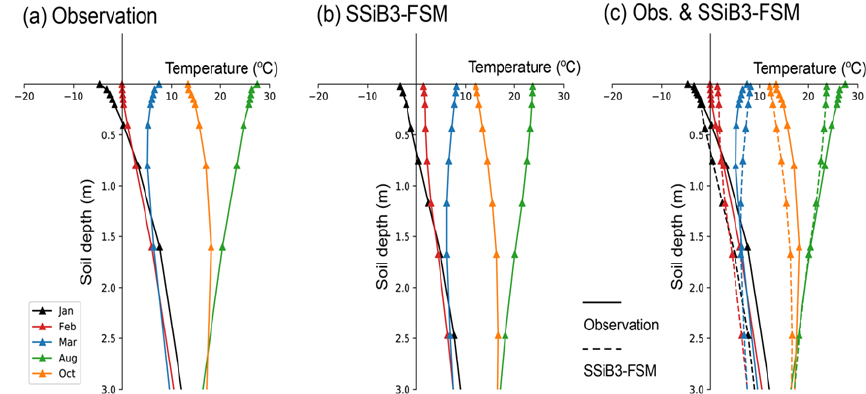
Figure 5. The seasonal soil temperature profile over NC (16 sites) for 1981–2005. (a) Observation; (b) simulated by SSiB3-FSM; (c) obser- vation and SSiB3-FSM.